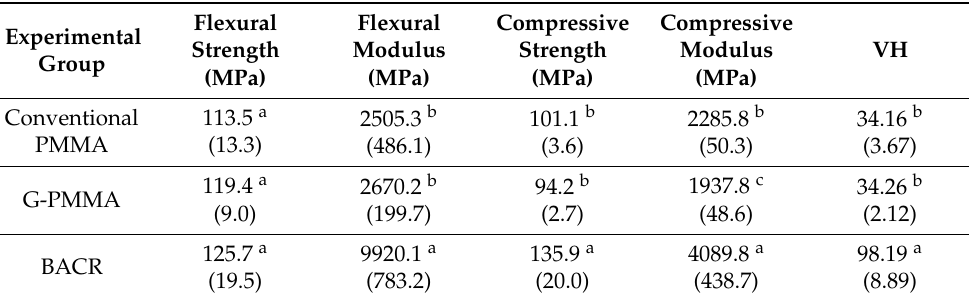
Table 2. Mean values and standard deviations for flexural strength (MPa), flexural modulus (MPa), compressive strength (MPa), compressive modulus (MPa), and VH. Different superscript letters indicate statistically significant